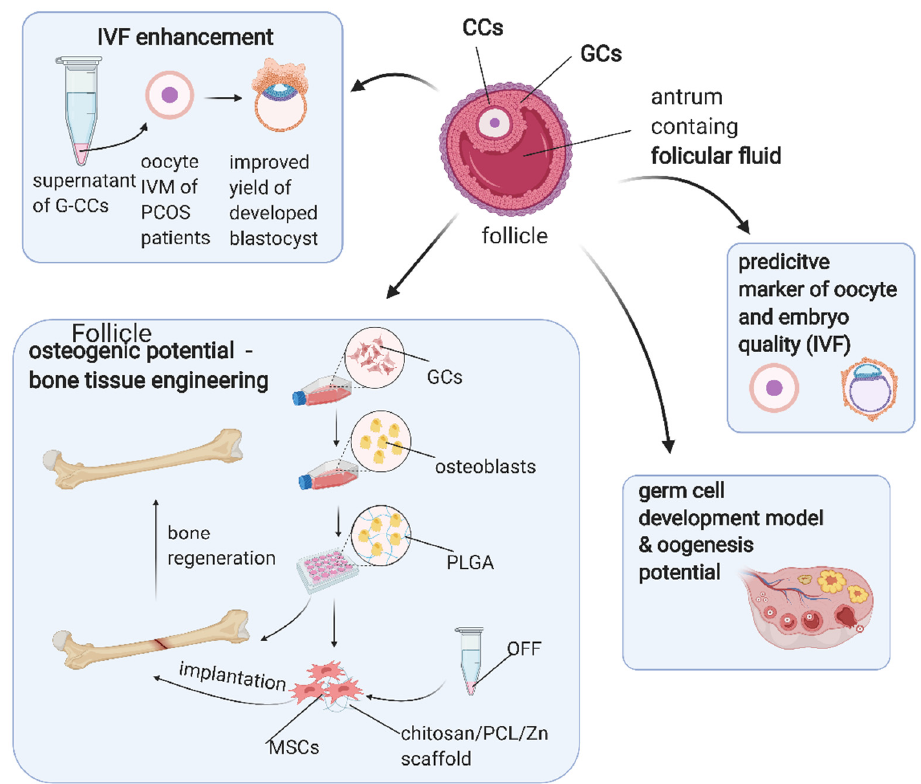
Figure 5. Possible clinical applications of ovarian follicular cells. Abbreviations—CCs: cumulus cells; G–CCs: granulosa–cumulus cells; GCs: granulosa cells; IVF: in vitro fertilisation; IVM: in vitro maturation; MSCs: mesenchymal stem cells; OFF: ovarian follicular fluid; PCL: polycaprolactone; PCOS: polycystic ovarian syndrome; PLGA: polylactic-co-glycolic acid. (Created with BioRender.com, accession date: 29.05.2021).